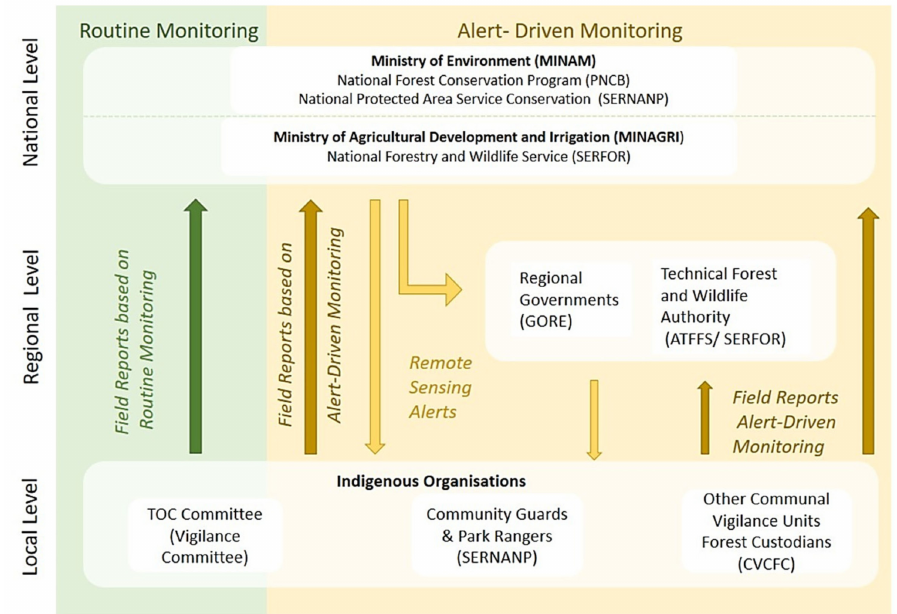
Figure 1. Community-based forest monitoring set-up,